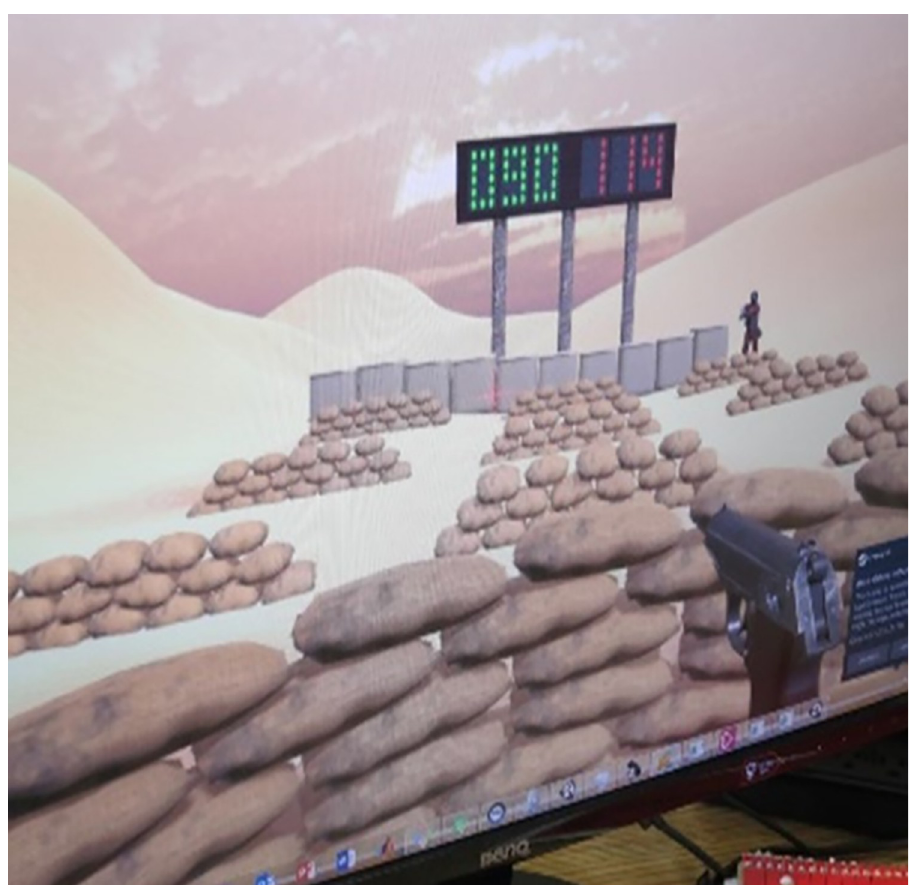
Fig 3. Go-NoGo shooting task. Single trial of SH task showing enemy target appearing at far right target location and current score feedback.